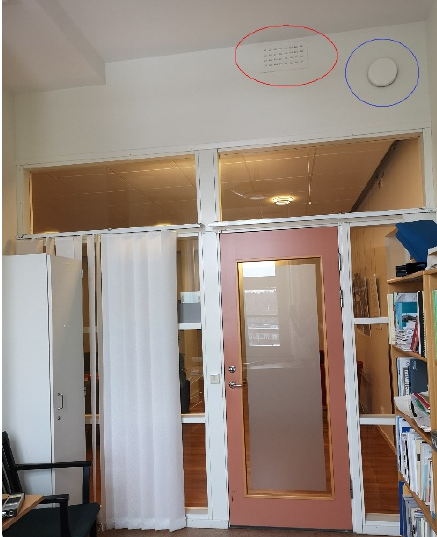
Figure 2. Picture taken from inside room B(s) on the wall facing the corridor. The red marking shows the supply air diffuser, and the blue marking shows the exhaust air diffuser.